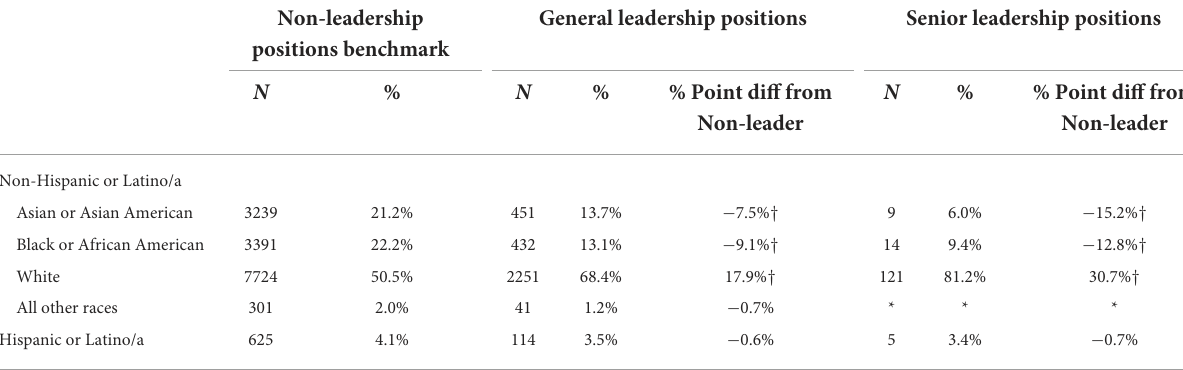
TABLE 1 Leadership gaps of employees by race and ethnicity in fiscal year